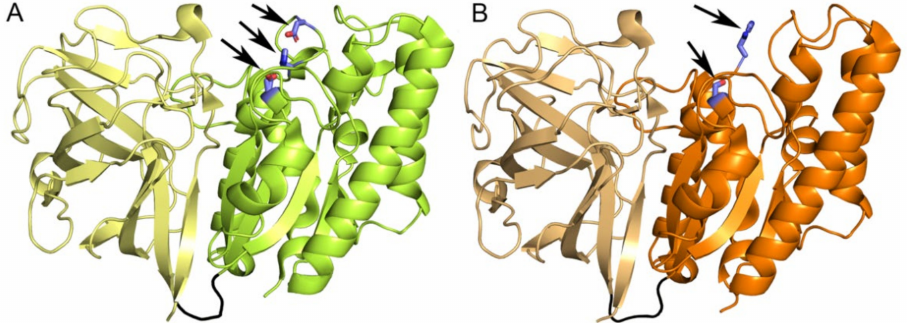
Figure 4. ( A ) A Crystal structure of acetyl xylan esterase from Prolixibacter bellariivorans . The N-terminal CBM domain is shown in pale yellow, SGNH domain in light green, and linker between them in black. The amino acid residues of the catalytic triad (Ser188, Asp363, and His366) are shown in blue sticks. ( B ) The crystal structure of acetyl xylan esterase from Chryseobacterium sp. The N-terminal CBM domain is shown in light brown, SGNH domain in orange, and linker in black. Catalytic Ser189 and Asp363 are shown in sticks.